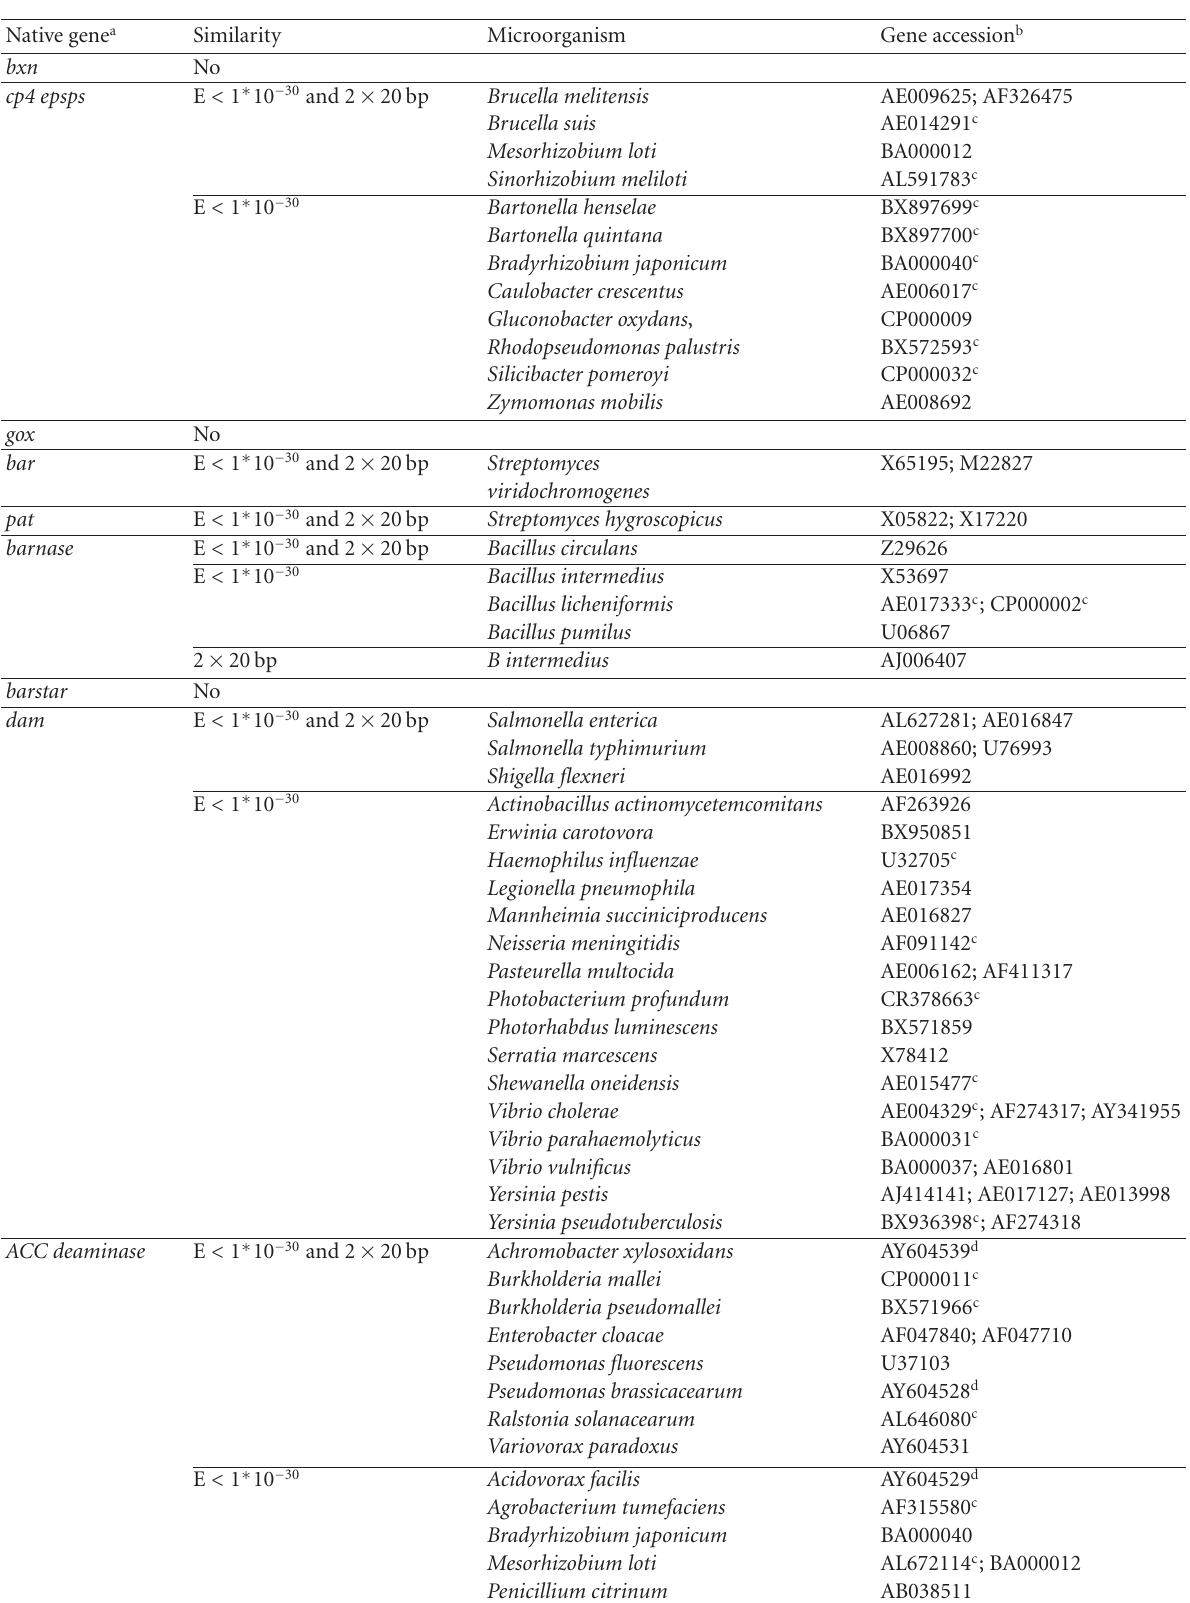
Table 2. Similarity of native microbial transgenes to other microbial sequences. Native gene